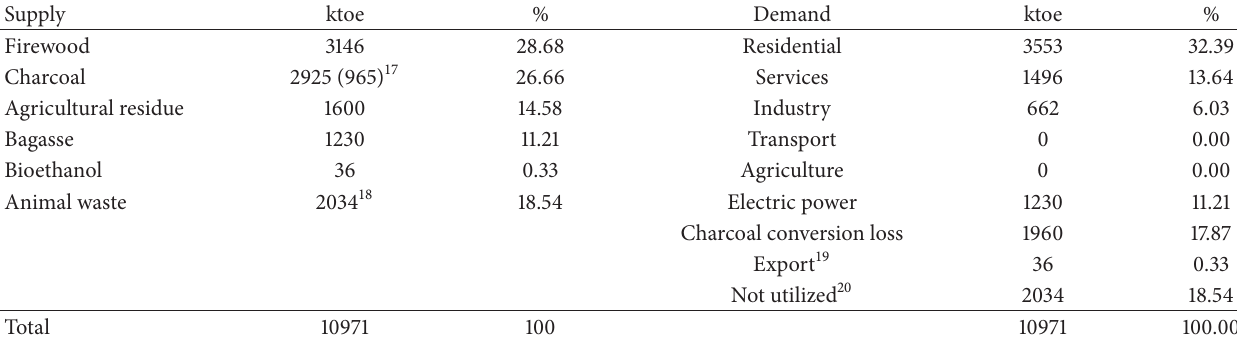
Table 24: Biomass supply and